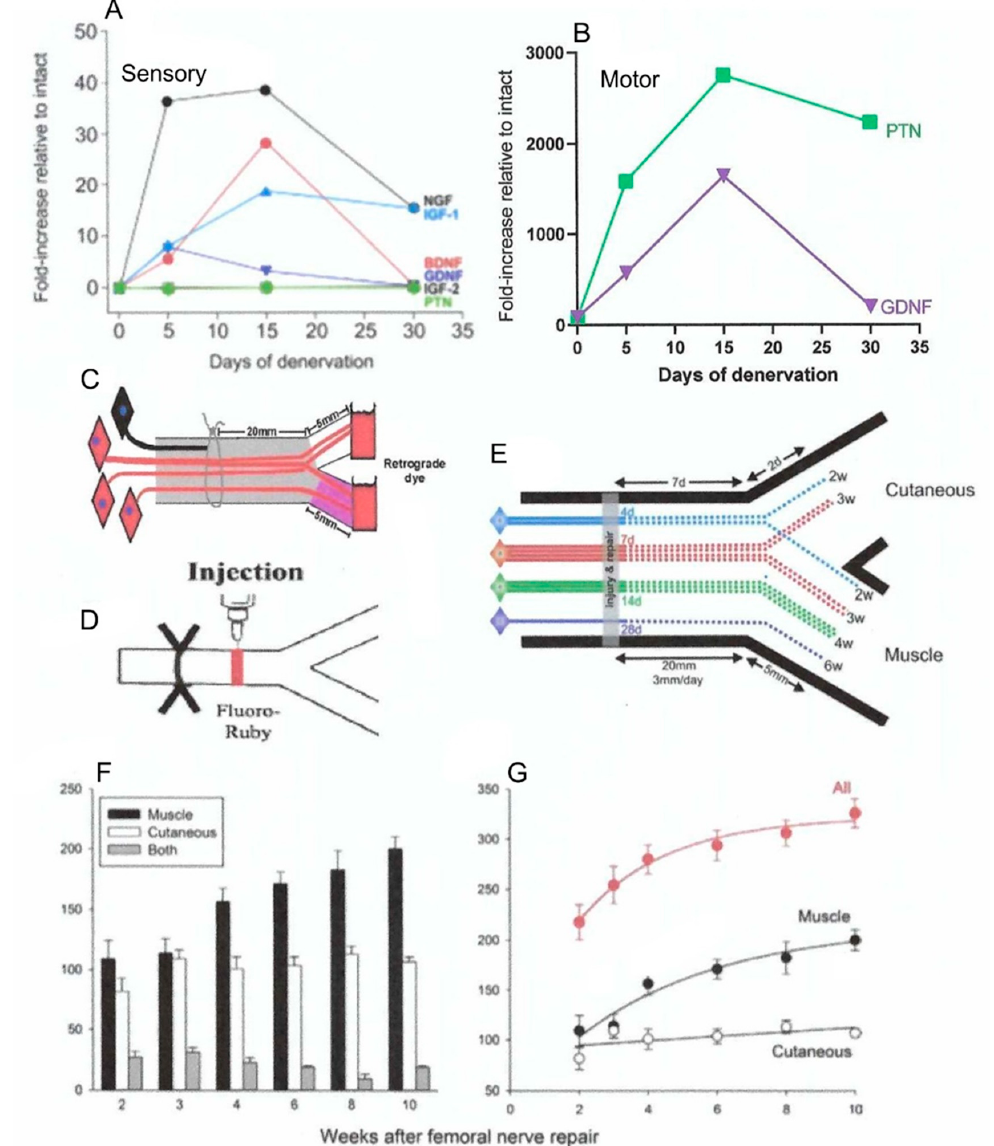
Figure 4. The expression of neurotrophic factors in Schwann cells in denervated nerve stumps and their role in preferential reinnervation of appropriate pathways by regenerating femoral nerves. The time course of the gene expression measured with rtPCR in the cutaneous sensory nerve branch of the femoral nerve ( A ) and in ventral root motor nerves ( B ). The mRNA normalized to values in innervated nerve stumps increased to a peak at 15 days and receded thereafter. Two di ff erent retrograde dyes (fluorogold and rubyred) were applied for retrograde labelling and counting of the motoneurons that regenerated their axons into appropriate and inappropriate motor (muscle) and sensory (cutaneous) nerve branches ( C ), and 1.5 mm across the site of microsurgical repair of the transected femoral nerve ( D ). The regeneration of the motor axons is non-selective at 2 and 3 weeks for the appropriate and inappropriate motor and sensory femoral nerve branches ( E ). However, as also shown by the data in ( F , G ), motoneurons progressively regenerate their axons preferentially into the motor branch in the time frame in which Schwann cells in the sensory and motor nerve branches show selective expression of growth factors ( A ). The number of motoneurons that had regenerated their axons non-selectively into both branches did not change over time ( F , G ). Adapted from